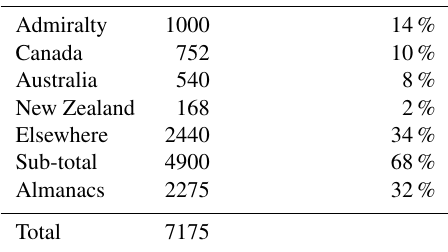
Table 4. TI’s income from predictions by region and type of client (D.BO 2/1/3/2, MMM – North Street). Analysis of prediction income 1956, in